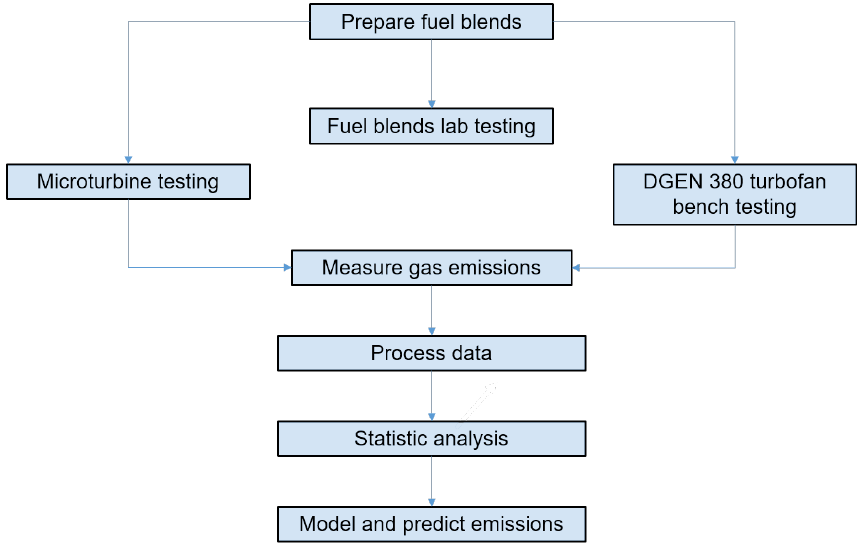
Figure 1. Testing